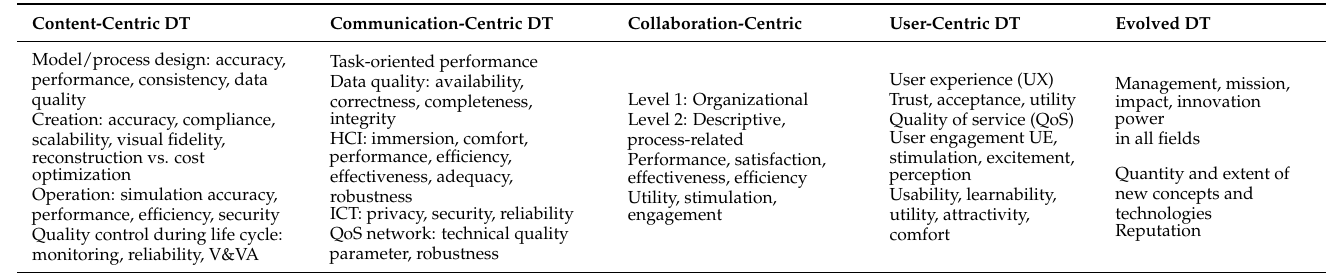
Table 4. Five most important dimensions of DT in our corpus-quality criteria and metrics. Content-Centric DT Communication-Centric DT Collaboration-Centric User-Centric DT Evolved